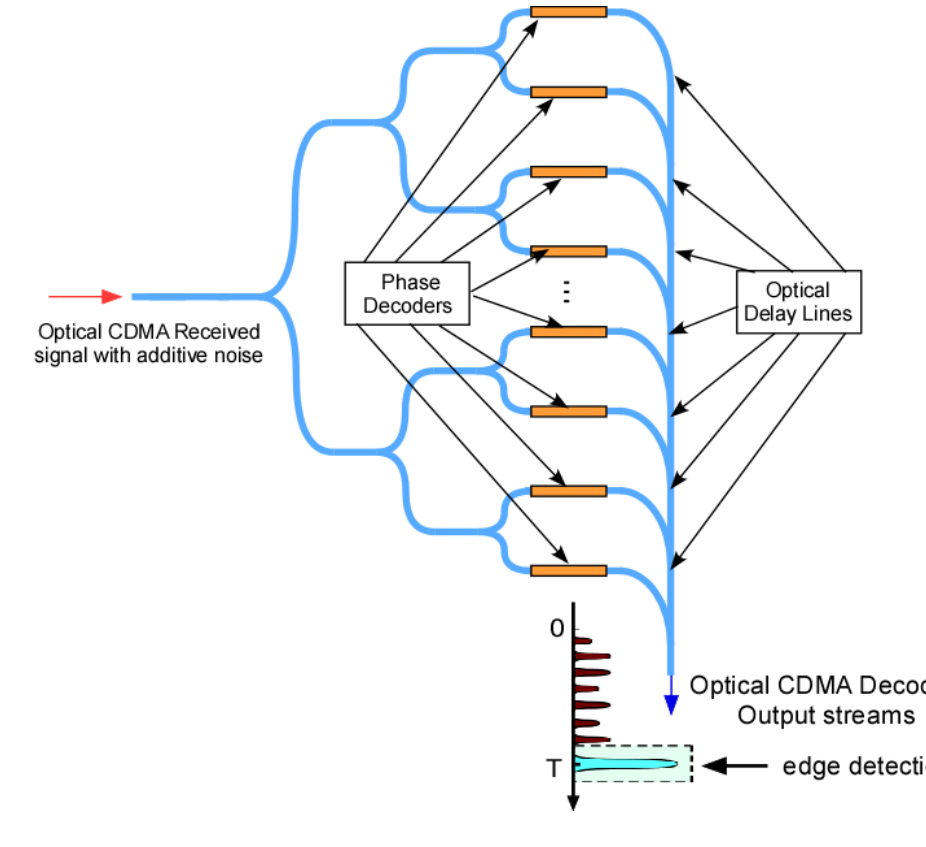
Figure 3. Schematic structure of the optical CDMA decoder for one channel. It consists of optical-time lines, optical combiners, and TO phase-decoders. The TO phase decoders are the same as in the optical CDMA encoder of the same channel. The optical CDMA decoders for other channels have the same structure with their own codes for the TO